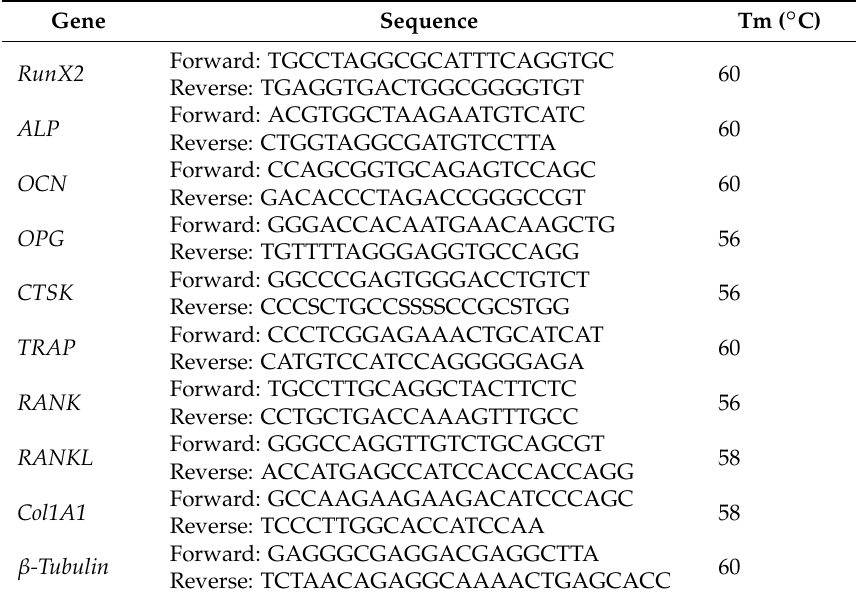
Table 1. Sequence and characteristics of primers used for